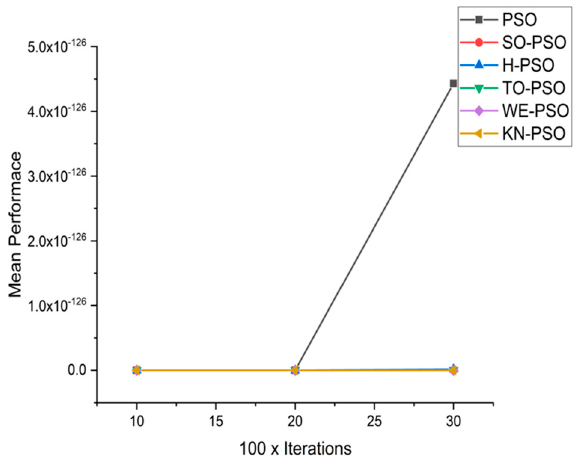
Figure 15. Convergence curve on fn9.